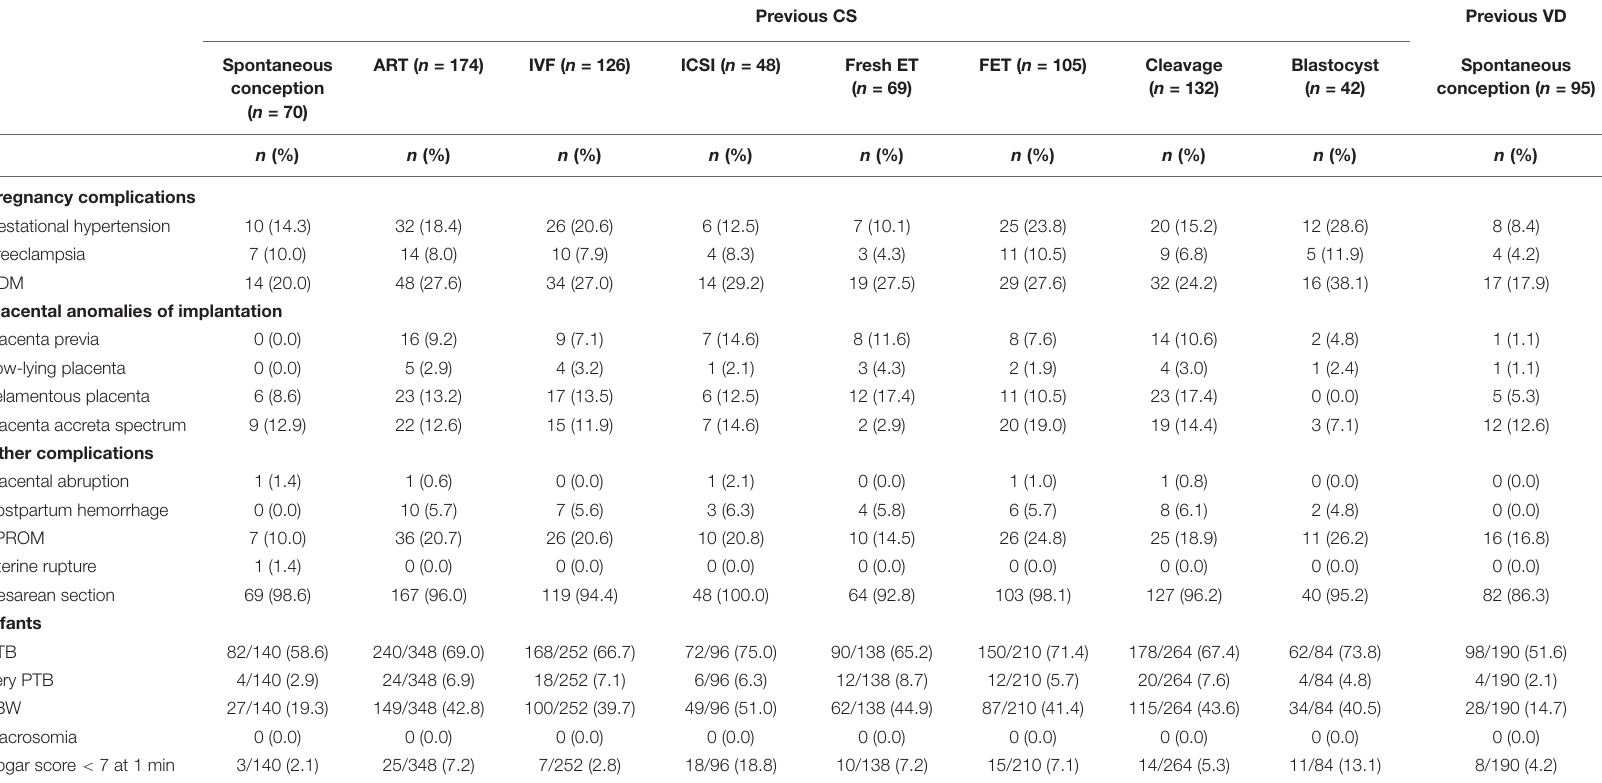
TABLE 4 | Obstetric and perinatal outcomes in subsequent twin pregnancies according to mode of delivery at the first